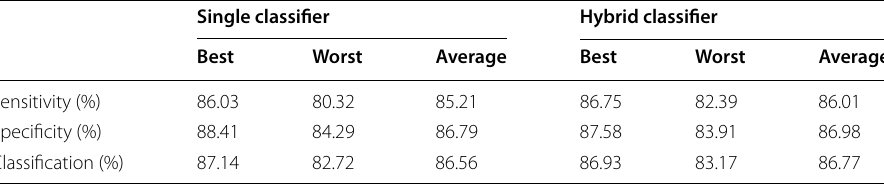
Table 3 Comparison of the single classifier with the embedded classifier